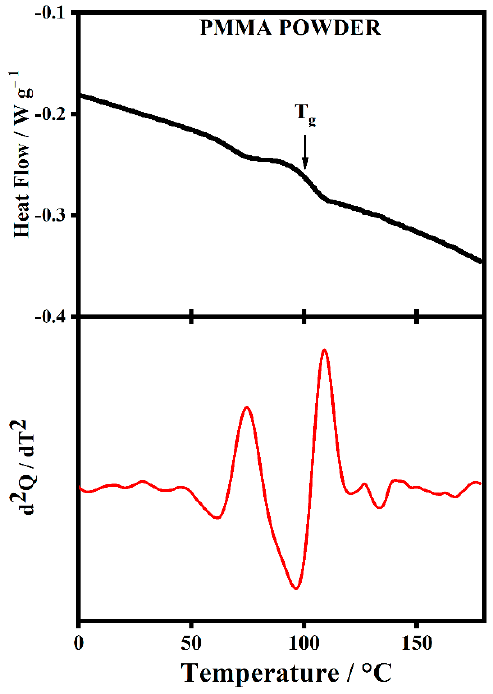
Figure 17. The Differential Scanning Calorimetry (DSC) curve (black solid curve) and the second derivative of the respective DSC signal (red dot curve) were collected during a heating process with a rate of 10 °C/min on PMMA pure powder.